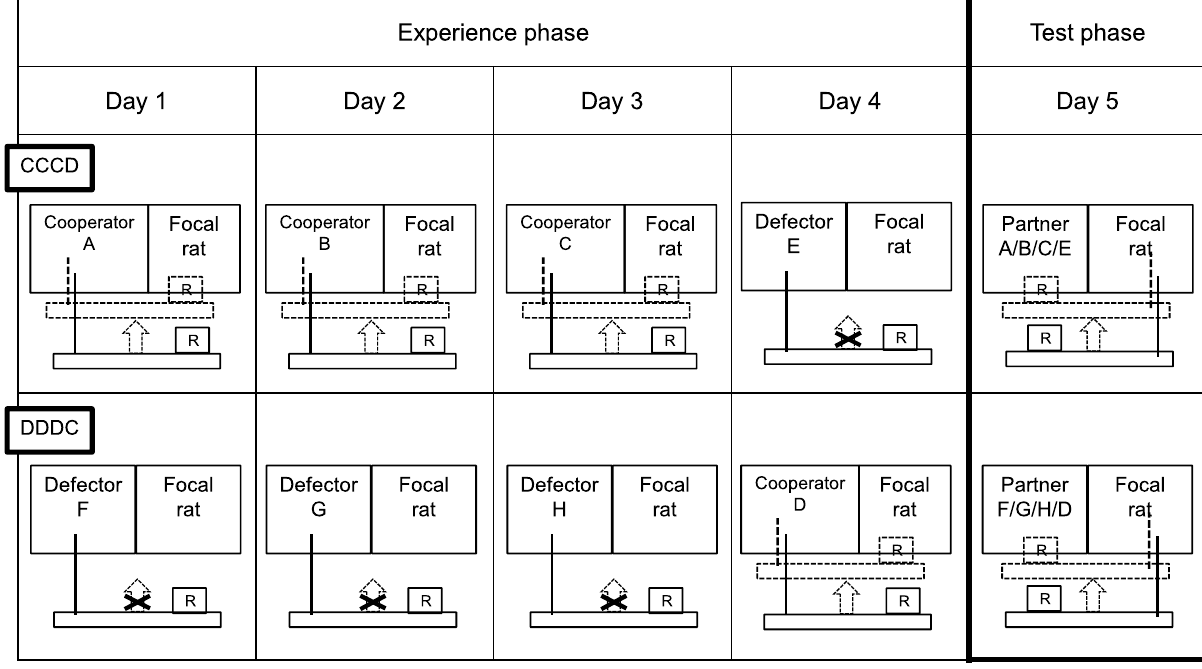
Figure 1. Experimental setup. During the experience phase, focal rats were paired with cooperating partners that provided food rewards (R) to them, or defecting partners that did not provide food rewards to them. In one treatment (CCCD), focal rats were paired with three different cooperators on three consecutive days, and a defector on the fourth day. In another treatment (DDDC), focal rats were paired with three different defectors on three consecutive days, and a cooperator on the fourth day. During the test phase, focal rats could provide food rewards to one of the partners they had encountered on the previous four days (partner A, B, C or E in treatment CCCD, and partner F, G, H or D in treatment